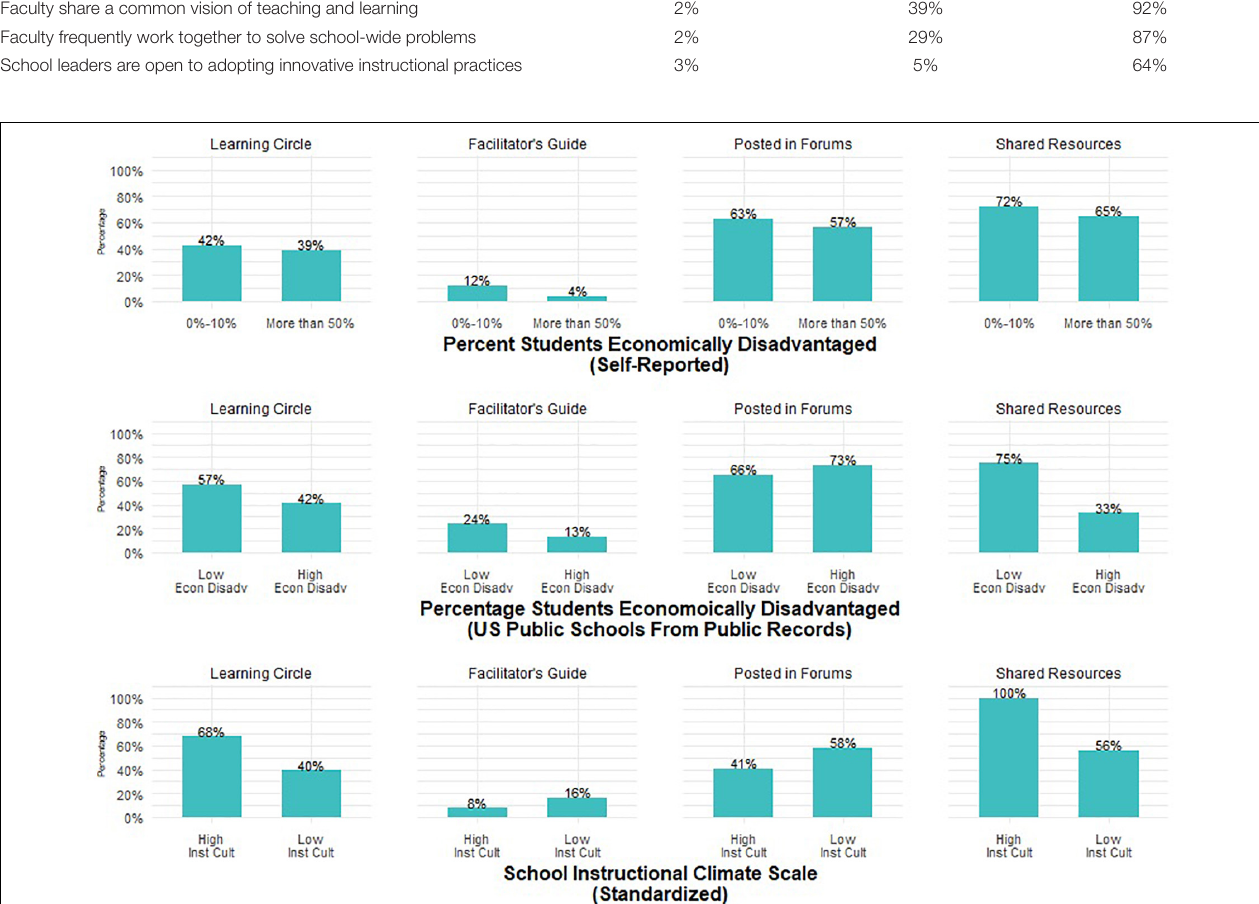
One standard deviation below the mean ( < –1.0)